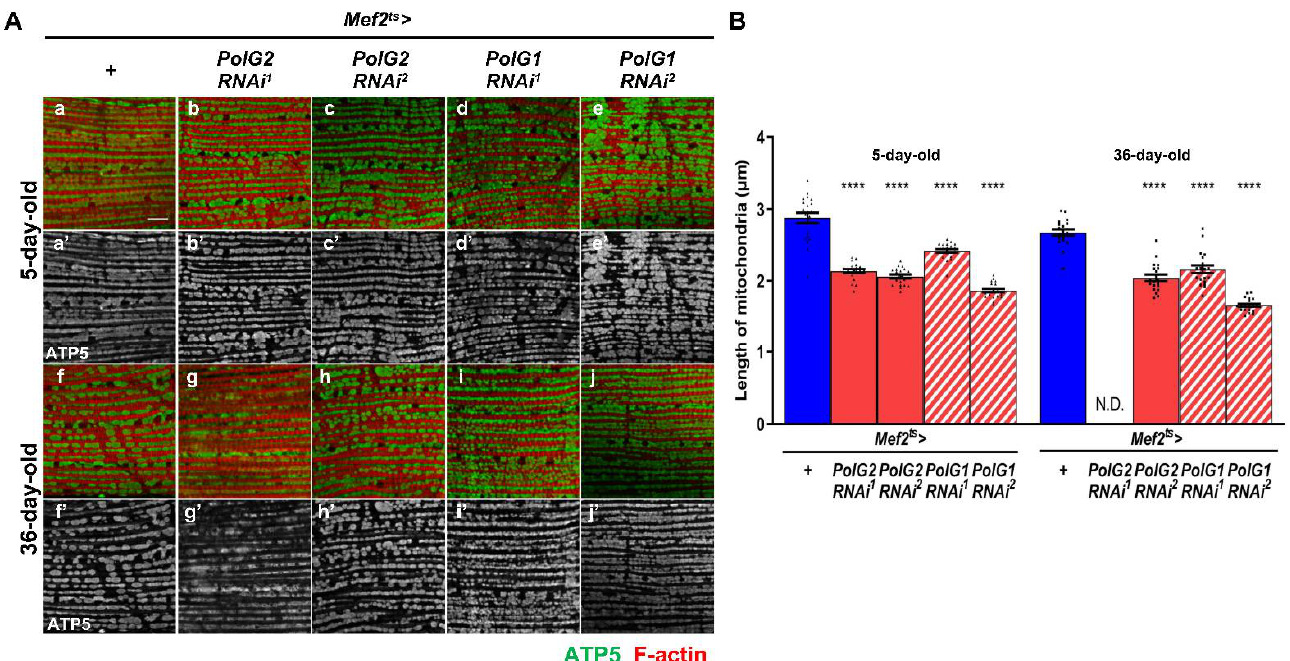
Figure 4. Observation of mitochondria by confocal microscopy and quantification of the mitochon- drial length in the adult IFMs harboring muscle-specific PolG1RNAi and PolG2RNAi . ( A ) Anti-ATP5A immunostaining of the IFMs collected from 5- and 36-day-old adults to visualize entire mitochondria of control adults ( Mef2 ts > + ) and adults harboring muscle-specific PolG1RNAi ( Mef2 ts > PolG2RNAi 1 and Mef2 ts > PolG2RNAi 2 ) and PolG1RNAi ( Mef2 ts > PolG1RNAi 1 and Mef2 ts > PolG1RNAi 2 ). Anti-ATP5A antibody staining (green in a – j , white in a’ – j’ ) and Alexa488-phalloidin staining for F-actin (red). Scale bar: 10 μm. ( B ) Quantification of muscular mitochondrial length in control adults ( Mef2 ts > + ) and adults harboring muscle-specific PolG2RNAi and PolG1RNAi ( Mef2 ts > PolG2RNAi 1 , Mef2 ts > PolG2RNAi 2 , Mef2 ts > PolG1RNAi 1 , and Mef2 ts > PolG1RNAi 2 ). 20 adult thoraxes at 5-day and 36-day old were examined in every genotype. N.D.; 36-day-old Mef2 ts > PolG2RNAi 1 flies contained mitochondria in which the mitochondrial membrane was too distorted to measure the length. ( n = 20, **** p < 0.0001, one-way ANOVA with Bonferroni’s multiple comparisons test). Error bar; s.e.m.